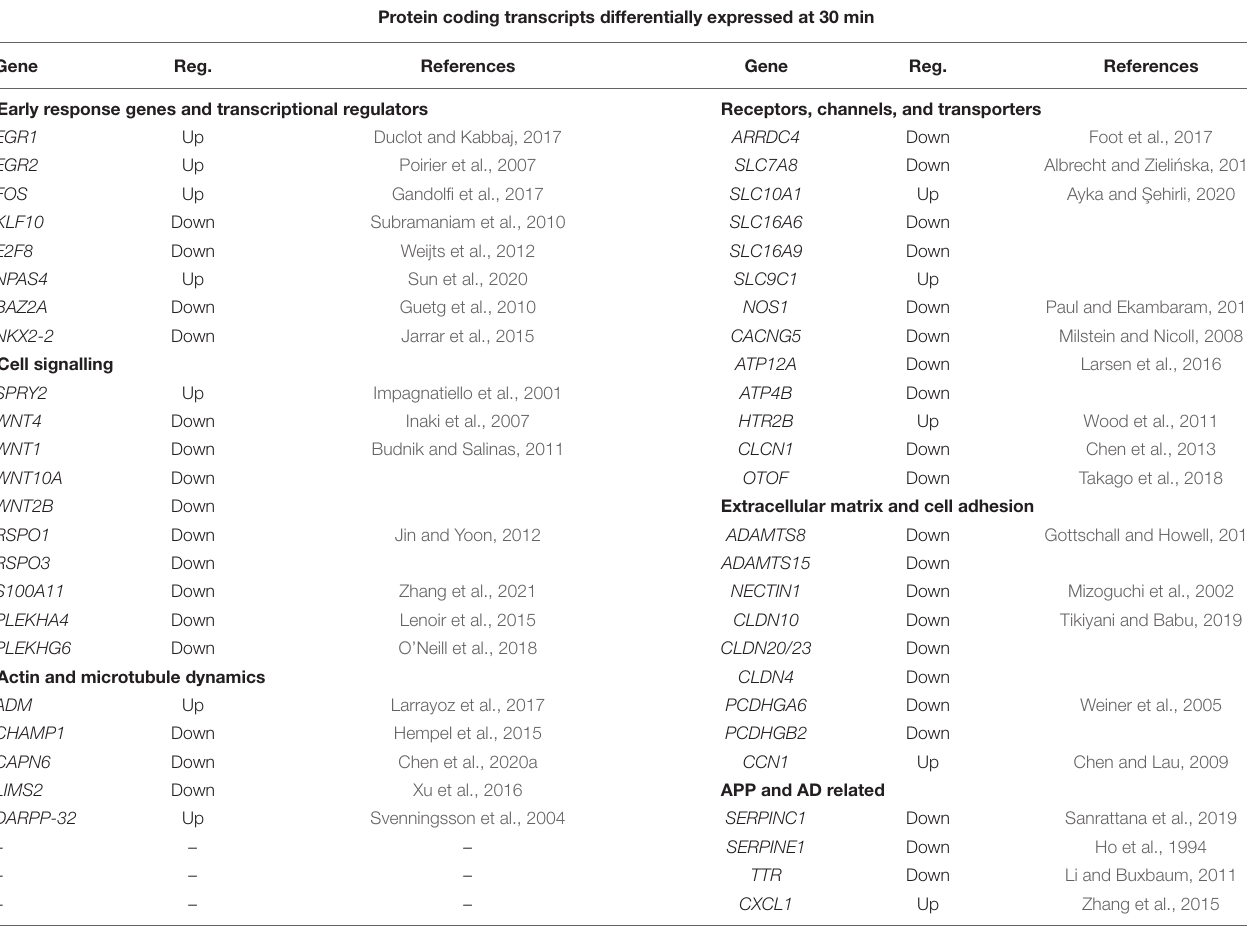
TABLE 2 | RNA sequencing data selection of protein coding genes differentially expressed after 30 min incubation with 1 nM sAPP α and their functions. Protein coding transcripts differentially expressed at 30 min